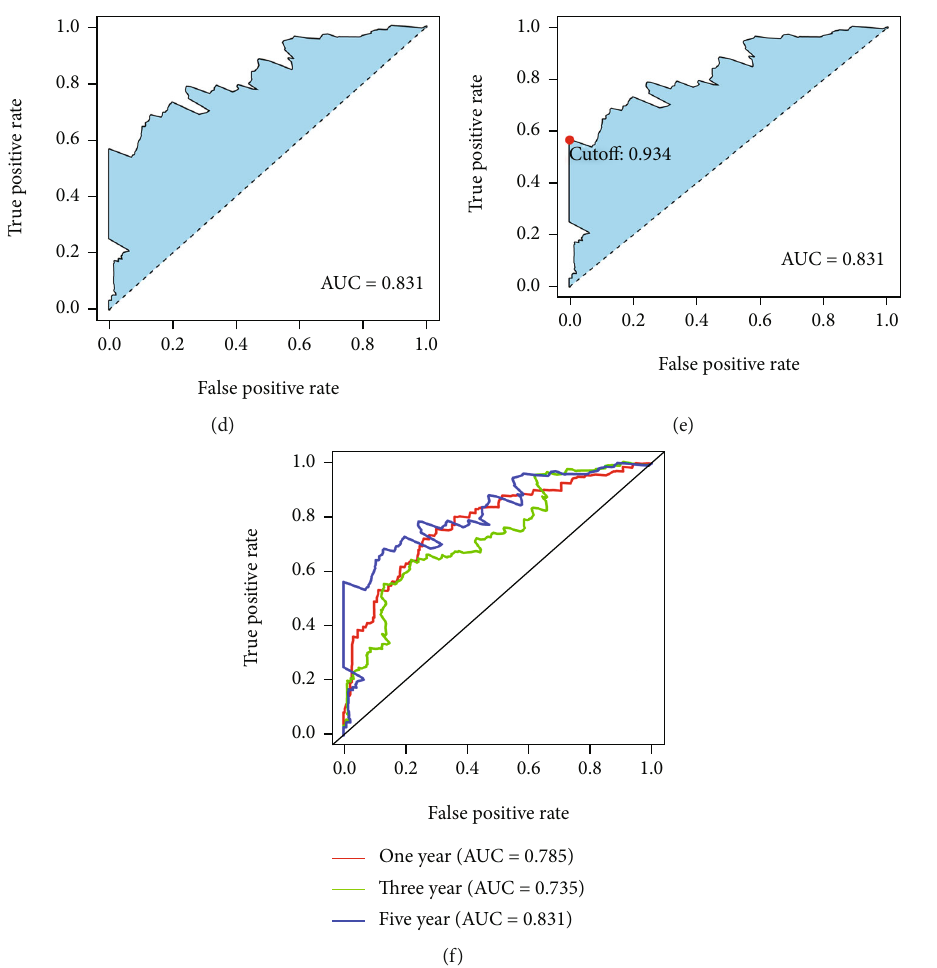
Figure 3: Construction of the risk model. Lasso regression analysis was performed to construct the prognosis ((a) and (b)). A total of 11 DEirlncRNAs pairs were included in the risk model (c). Roc curves were plotted to assess the accuracy of the risk model in predicting patients ’ survival ((d) –